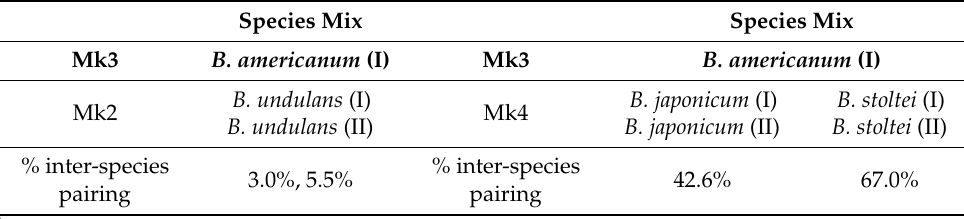
Table 3. Pairing capacity between species in complementary gamone-pretreated cells 1 .